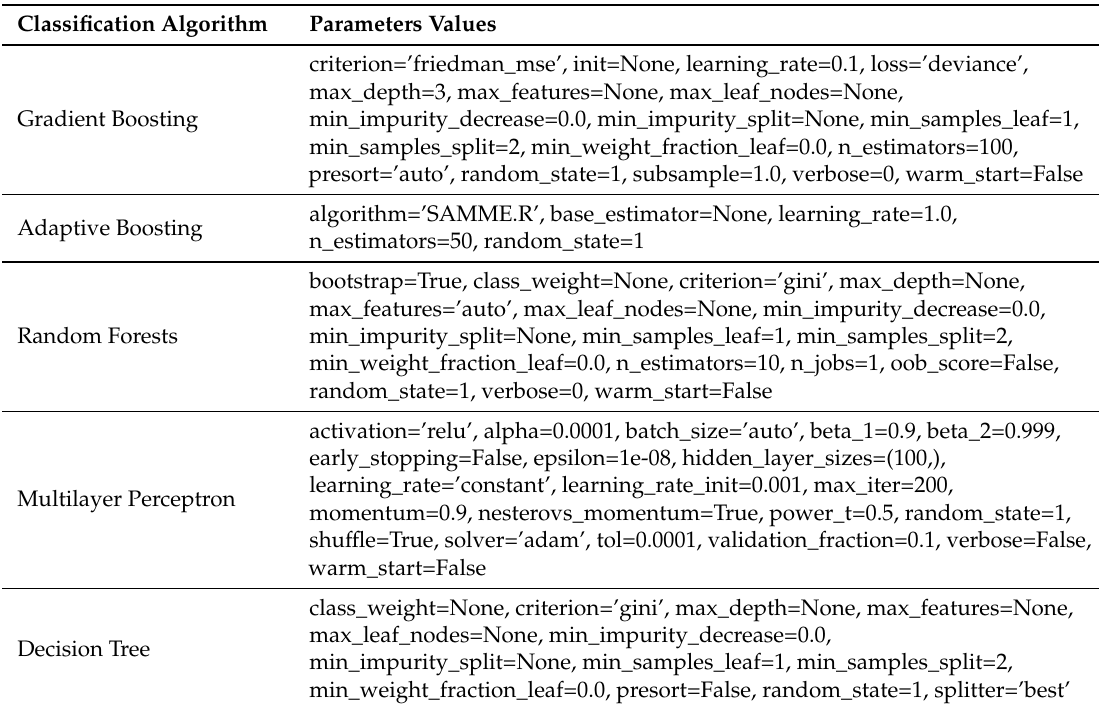
Table 10. Algorithms